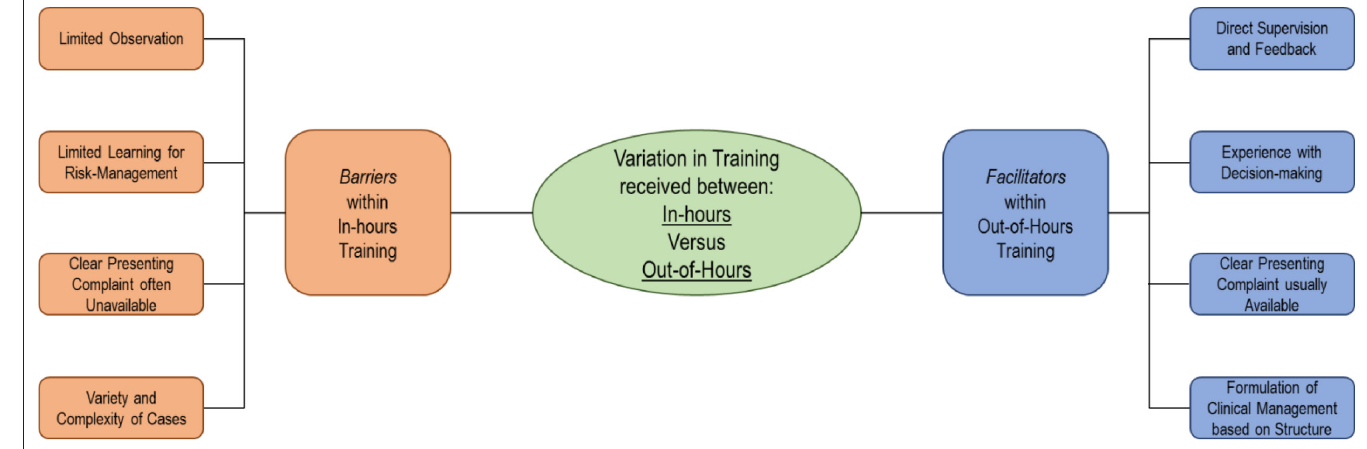
Figure 4 Factors shaping in- hours and out- of- hours training: barriers and